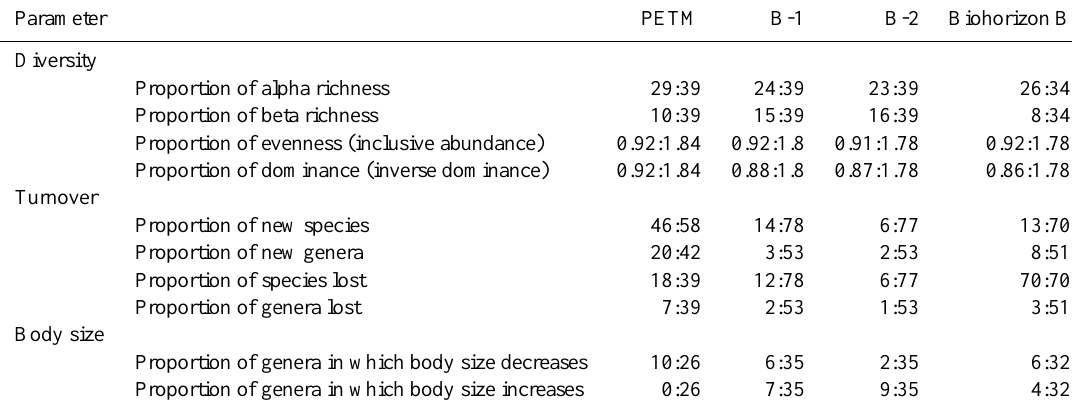
Table 2. Comparison of faunal change at the PETM and faunal events B-1 and B-2. Summary paleoecological parameter values are calculated for the entire PETM sample (Rose et al., 2012) and the entire faunal event B-1 and B-2 samples. Proportions of taxa lost at the PETM are based on the Clarkforkian (late Paleocene) Bighorn Basin mammal fauna described in Rose (1981). Proportions of change in body size at the PETM are from Secord et al. (2012). Proportions of change in body size at faunal events B-1 and B-2 are based on the total number of taxa for which body size can be